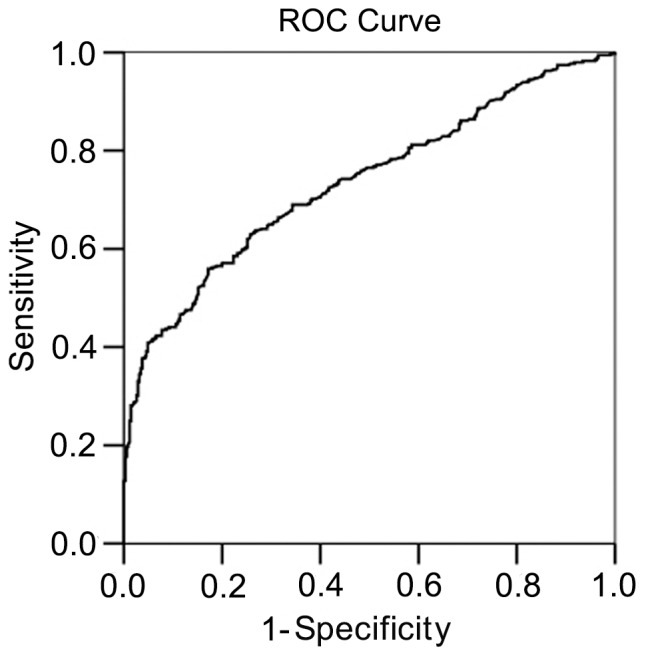
Receiver operating characteristic curves for APE1-AAbs level for NSCLC detection.Serum concentrations of APE1-AAbs levels among 292 NSCLC patients and 300 healthy controls were determined by ELISA. The diagnostic potentials of APE1-AAbs were assessed by ROC curves. The AUC value was 0.745.